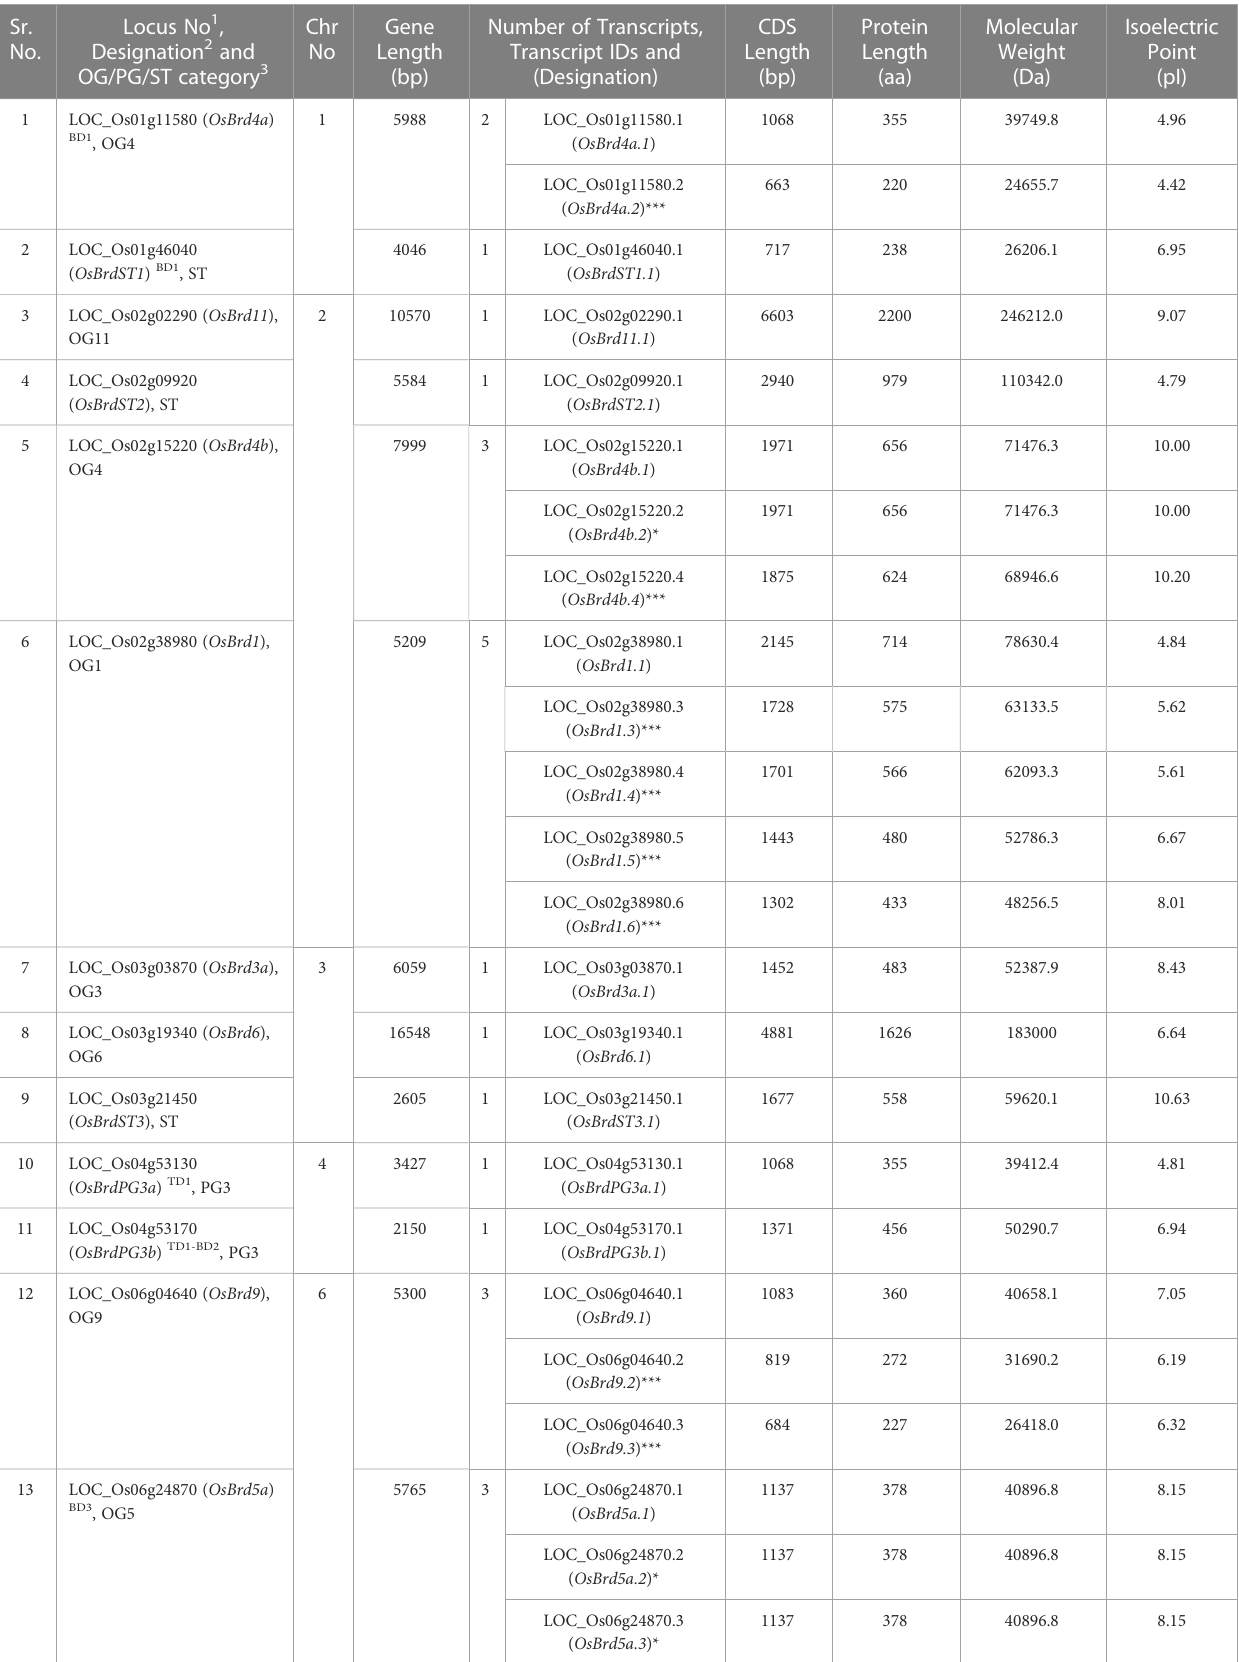
TABLE 2 An overview of characteristics of 22 bromodomain-containing genes ( Brd -genes) in Oryza sativa genome. Sr.